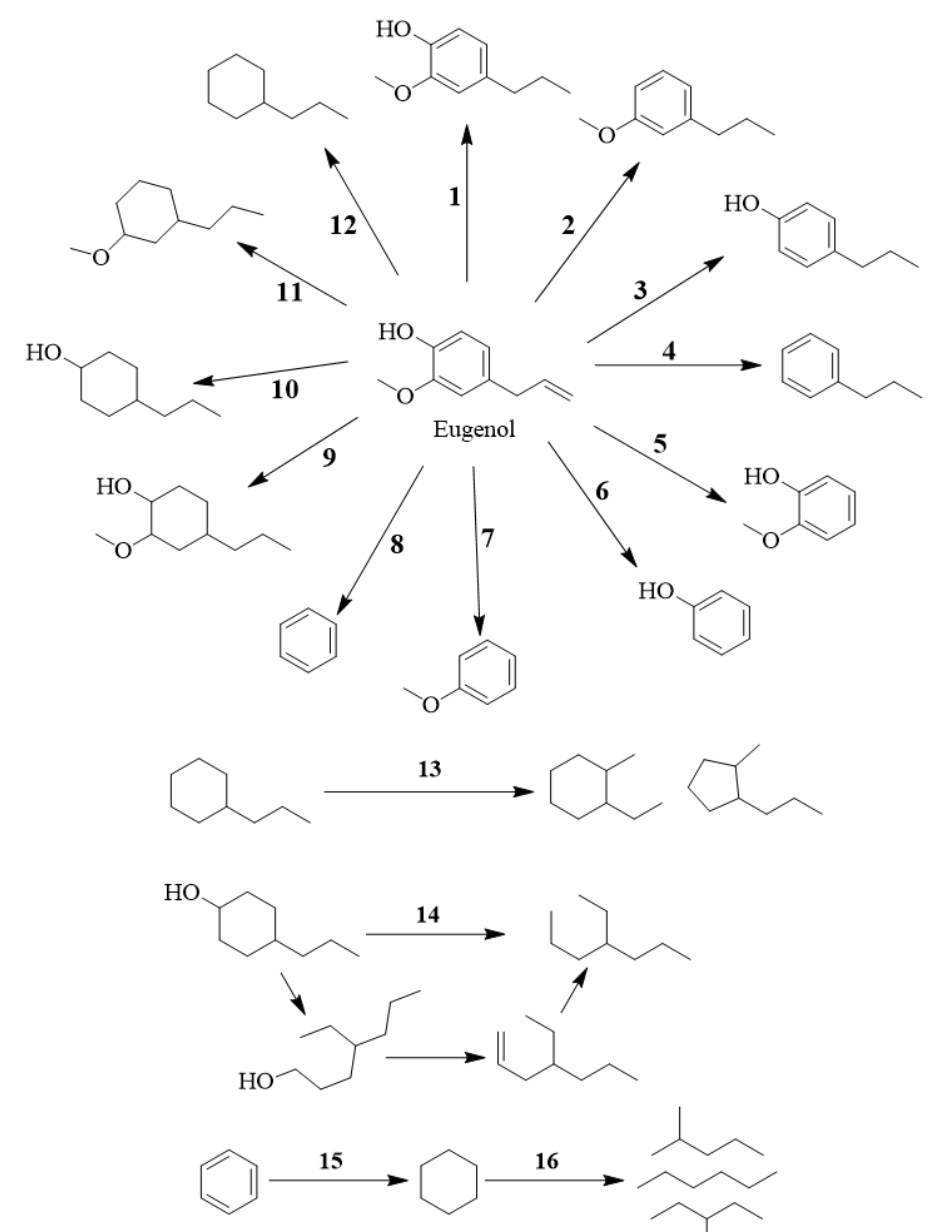
Figure 3. Reactions and related products from eugenol under H 2 environment. Side reactions of formed hydrocarbons during hydrodeoxygenation-hydrogenation of lignin-derived aromatic compounds.